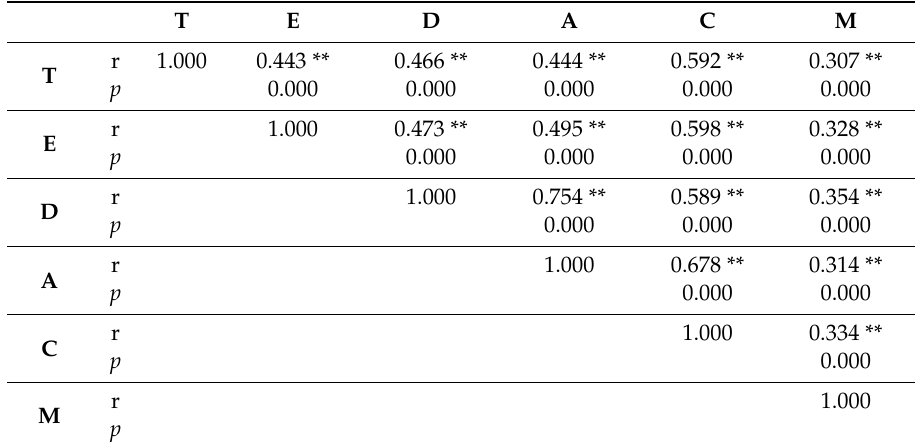
Table 3. Results of the bivariate correlations of the items from the 6 dimensions of the